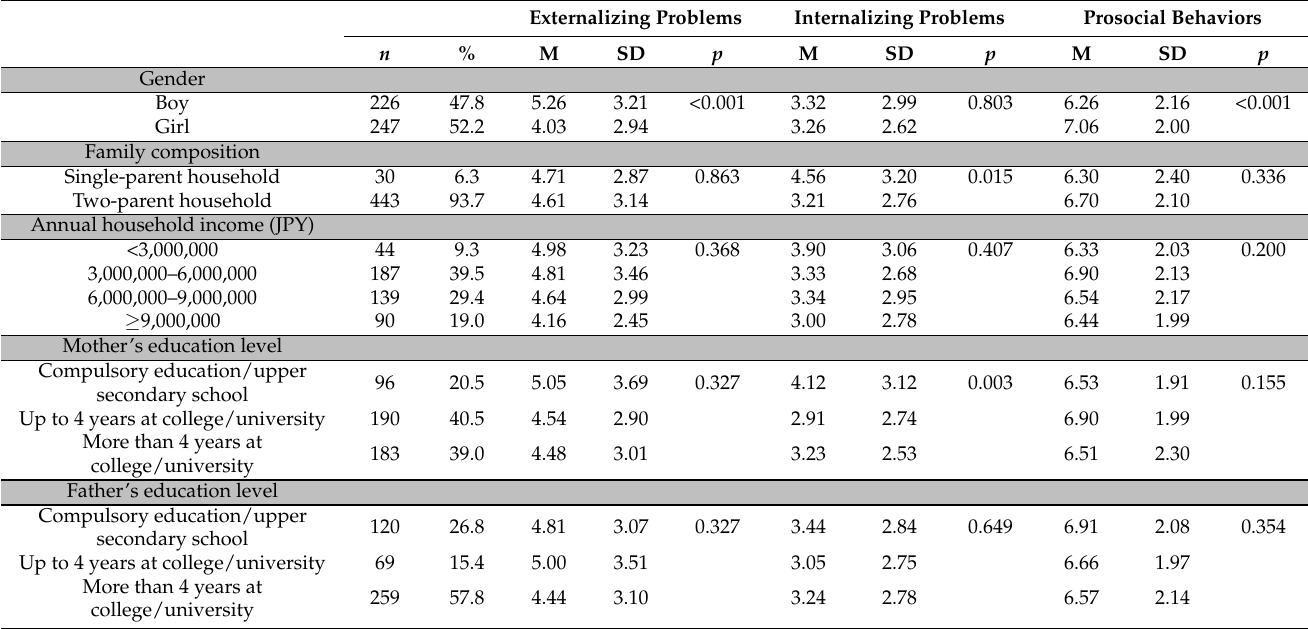
Table 1. Participants’ and children’s